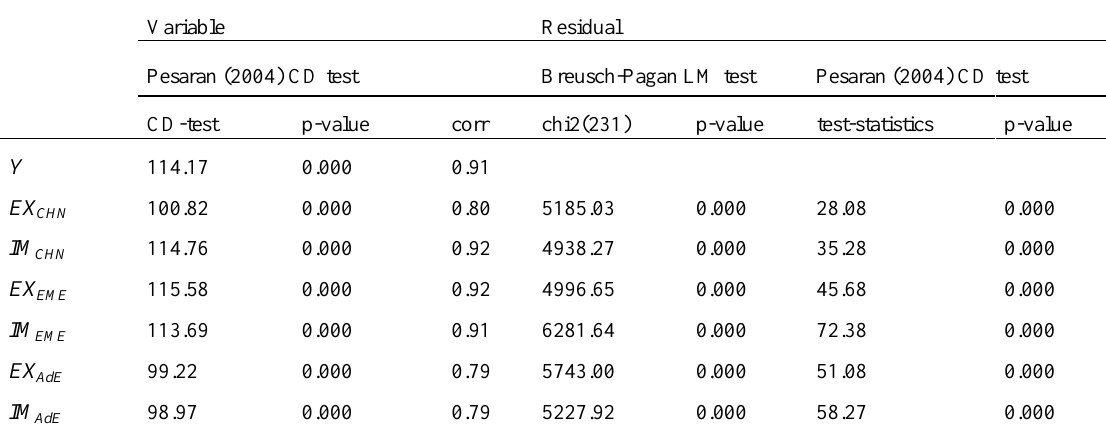
Table 1 : Cross-sectional dependence tests for variables and